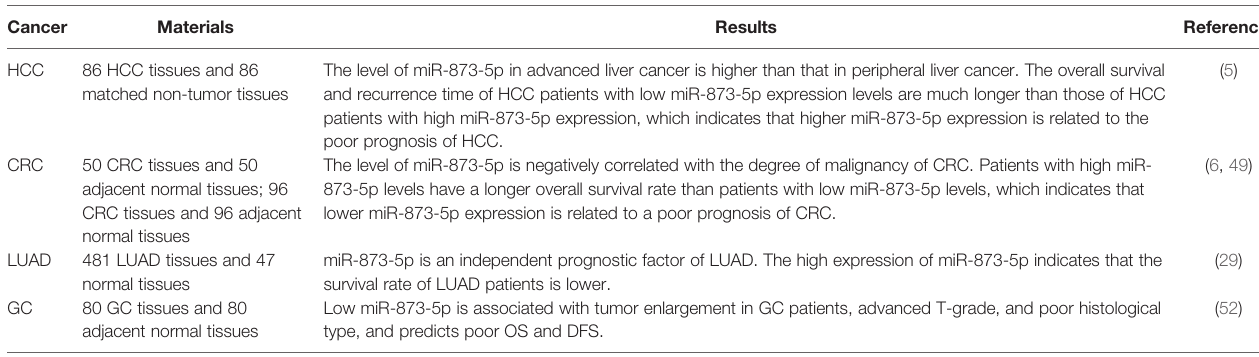
TABLE 2 | The prognostic value of miR-873-5p in different